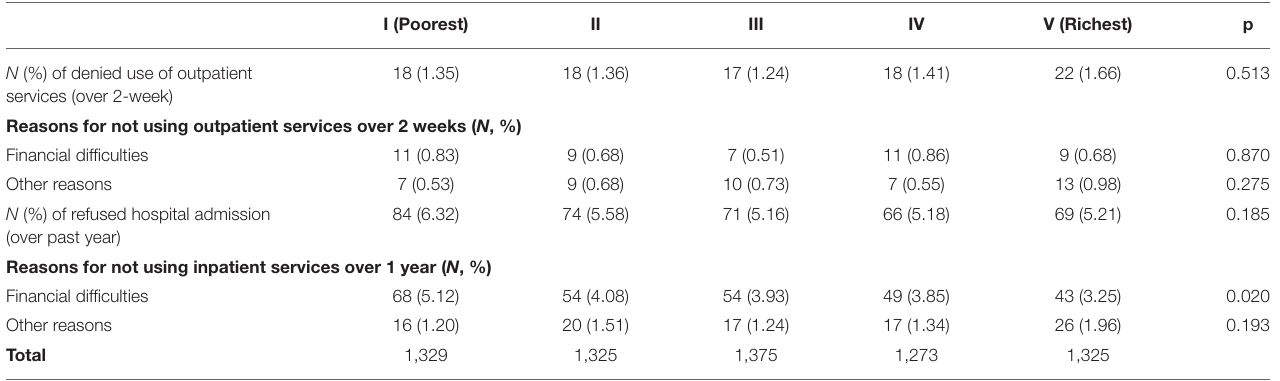
TABLE 3 | Situation that participants were denied outpatient and inpatient services across household income